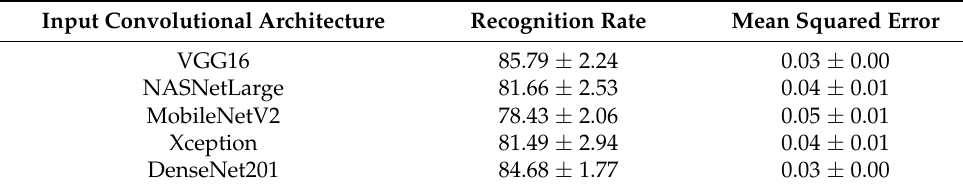
Figure 4. Changes in the loss (mean square error (MSE)) function during the training of the neural network with the VGG16 input layer. Time is measured in epochs. Each line represents a different random training set. After 2000 epochs, we observed smaller variance in the loss caused by reducing the learning rate from 0.001 to 0.0001. Table 2. Recognition rate and mean square error of networks with various input convolutional archi-